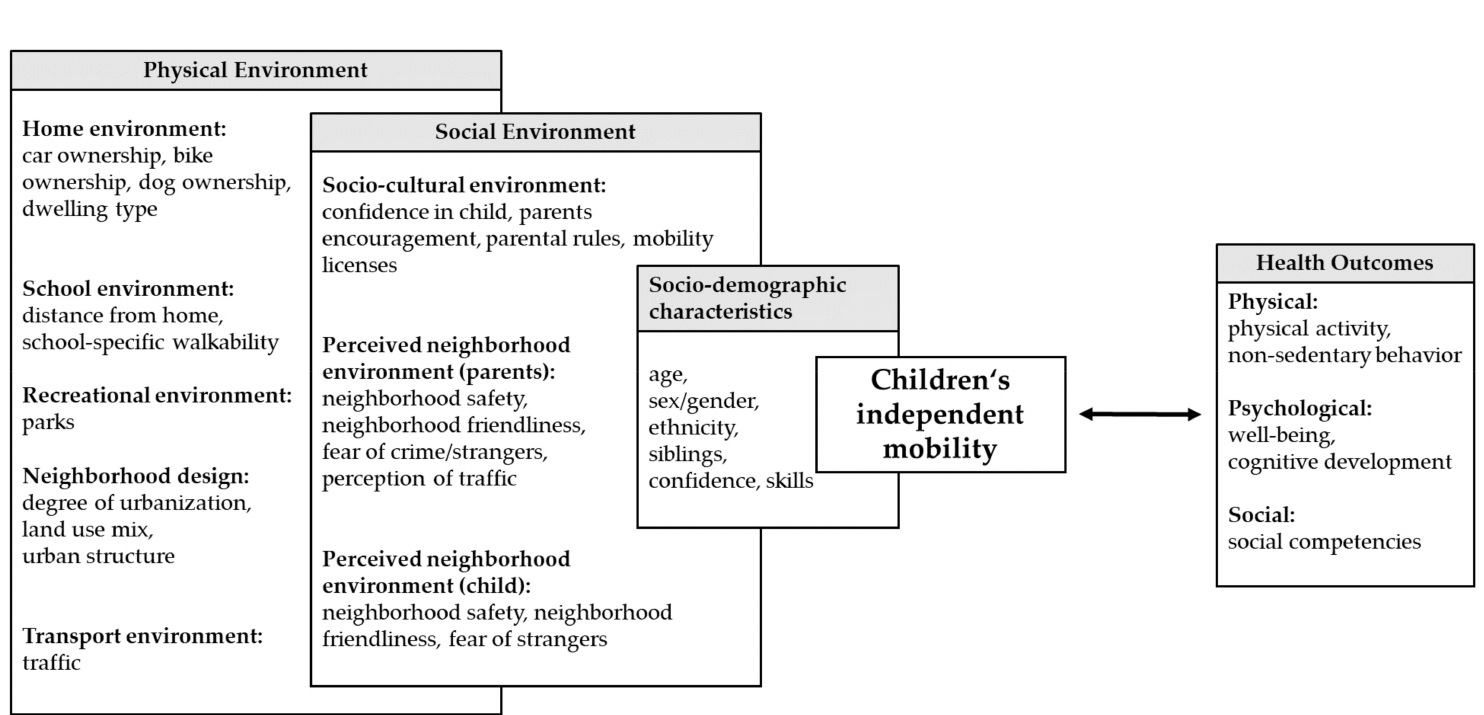
Figure 2. Summary of environmental correlates of CIM based on a socio-ecological perspective, according to Sallis et al.